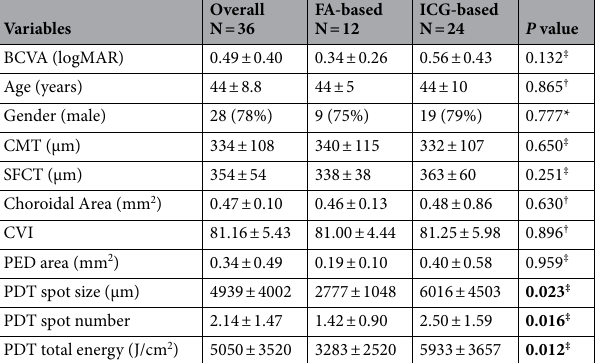
FA–guided PDT (mean ±